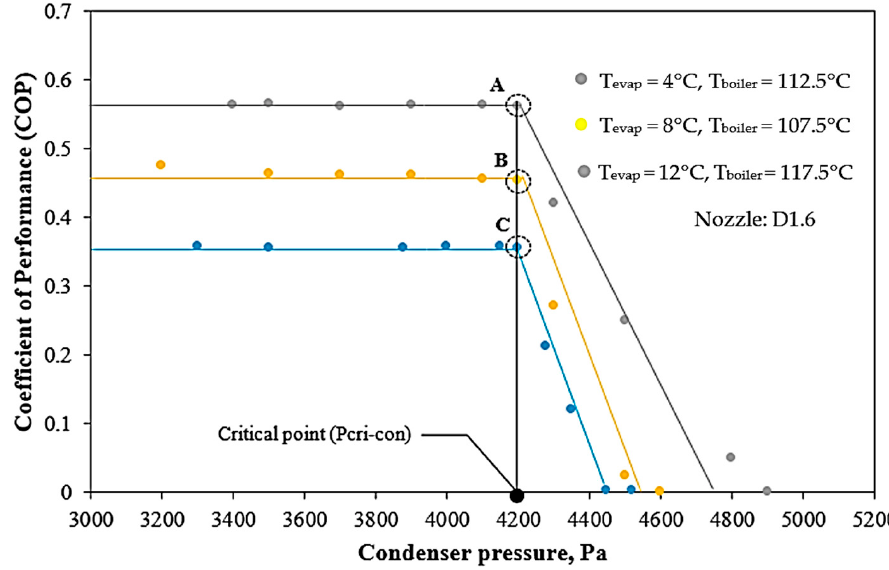
Figure 6. The conventional performance curve: impact of the evaporator temperature.